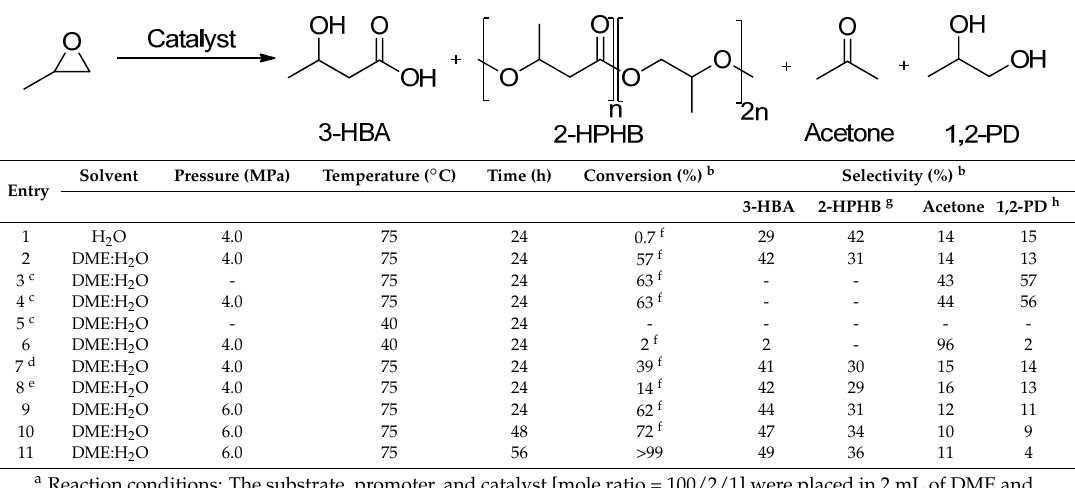
a Reaction conditions: The substrate, promoter, and catalyst [mole ratio = 100/2/1] were placed in 2 mL of DME and pressurized with CO at room temperature. b Determined by 1 H ‐ NMR spectroscopy with naphthalene as an internal standard. c Without catalyst. d Without promoter. e Excess promoter. f